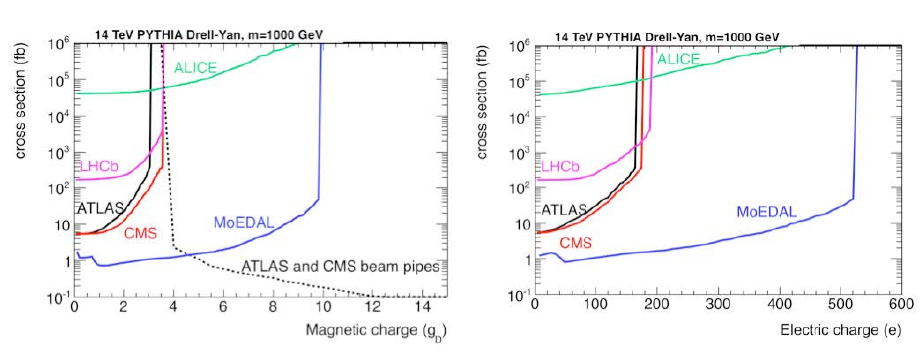
Figure 5. The expected reach [4] of the search for direct monopole anti-monopole Drell-Yan pair production process at the LHC (Ecm = 14 TeV). Assuming the luminosity taken by LHCb / MoEDAL is 2 fb − 1 , by ATLAS & CMS 20 fb − 1 , and by ALICE 0.004 fb − 1